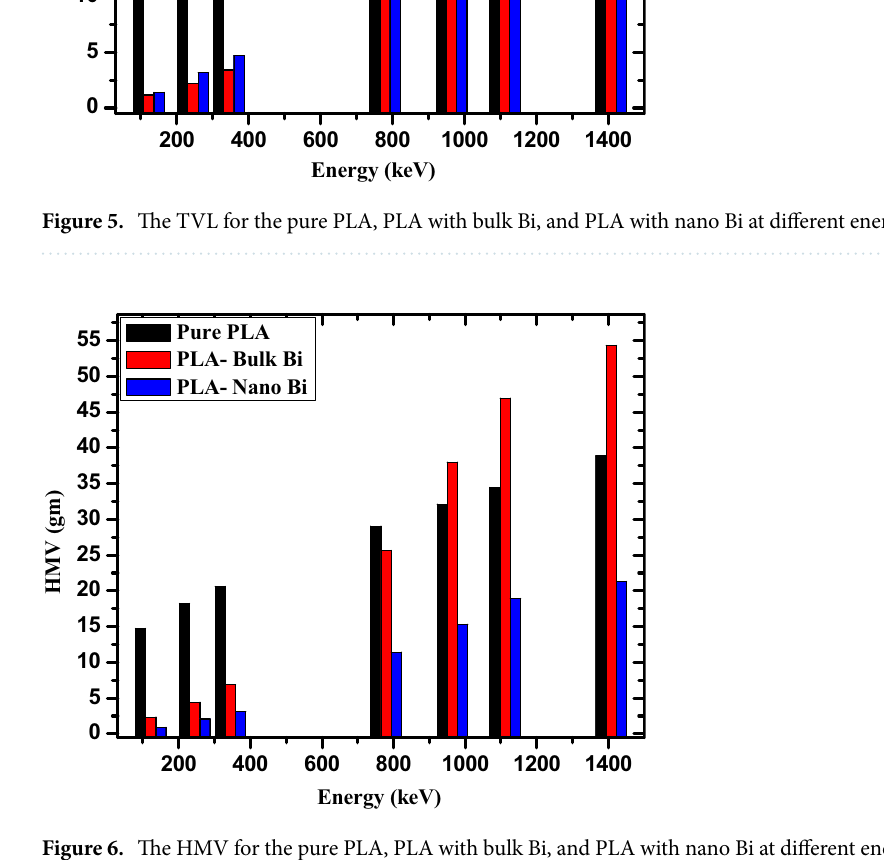
Figure 6. The HMV for the pure PLA, PLA with bulk Bi, and PLA with nano Bi at different